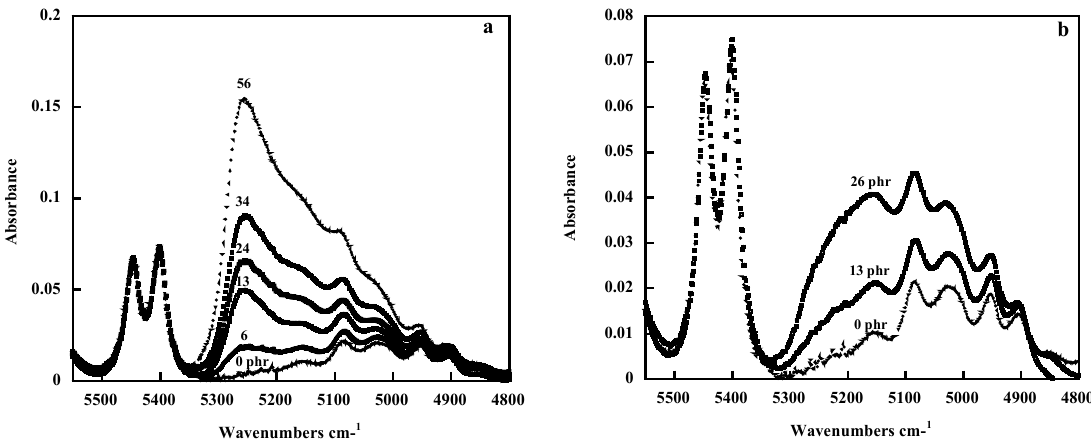
Figure 7. Near-infrared spectra in the 4800–5600 cm − 1 range of pure PDMS and of PDMS/SiO 2 ( a ) and PDMS/TiO 2 ( b ) composites: each curve is labelled with the amount of filler in phr (parts per hundred parts of rubber). Reprinted from reference [59] with permission from Wiley.